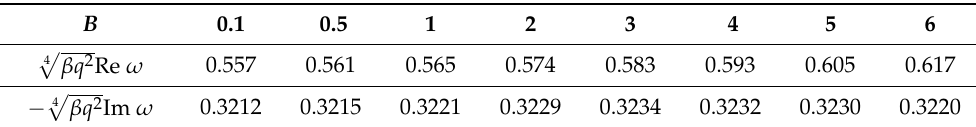
Table 2. The real and the imaginary parts of the frequencies vs. the parameter B at n = 1, l = 5, A = 7, C =